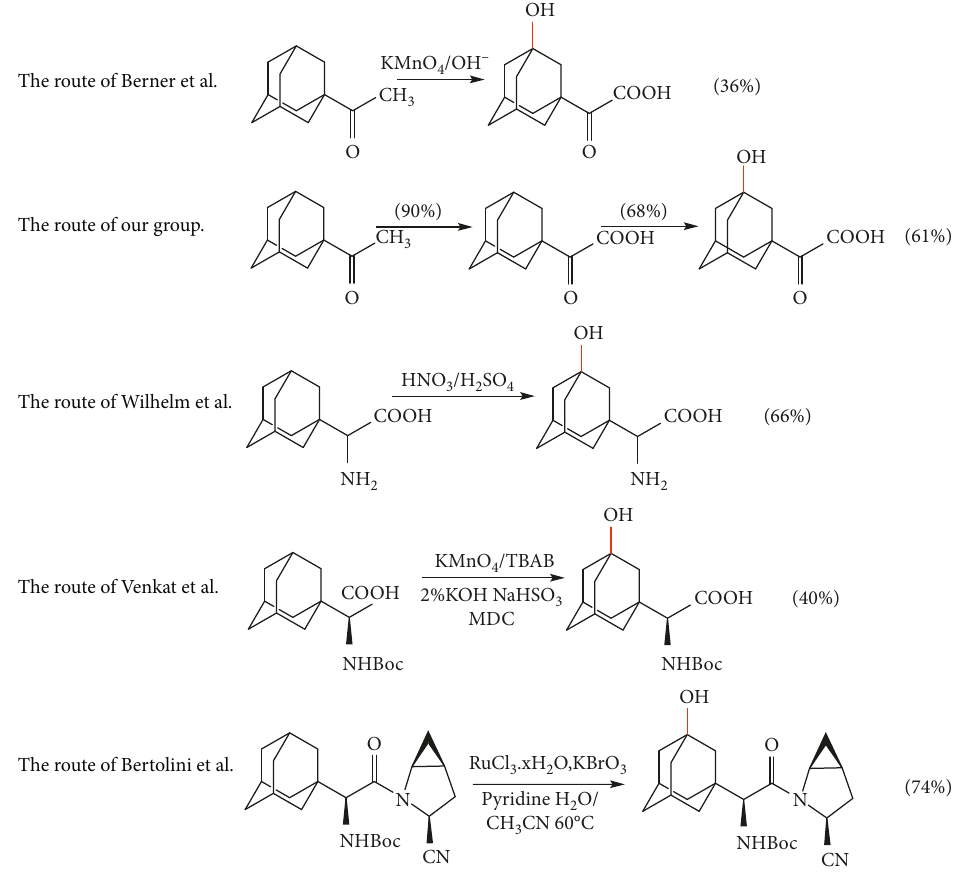
Figure 3: The existing methods to introduce the hydroxyl.